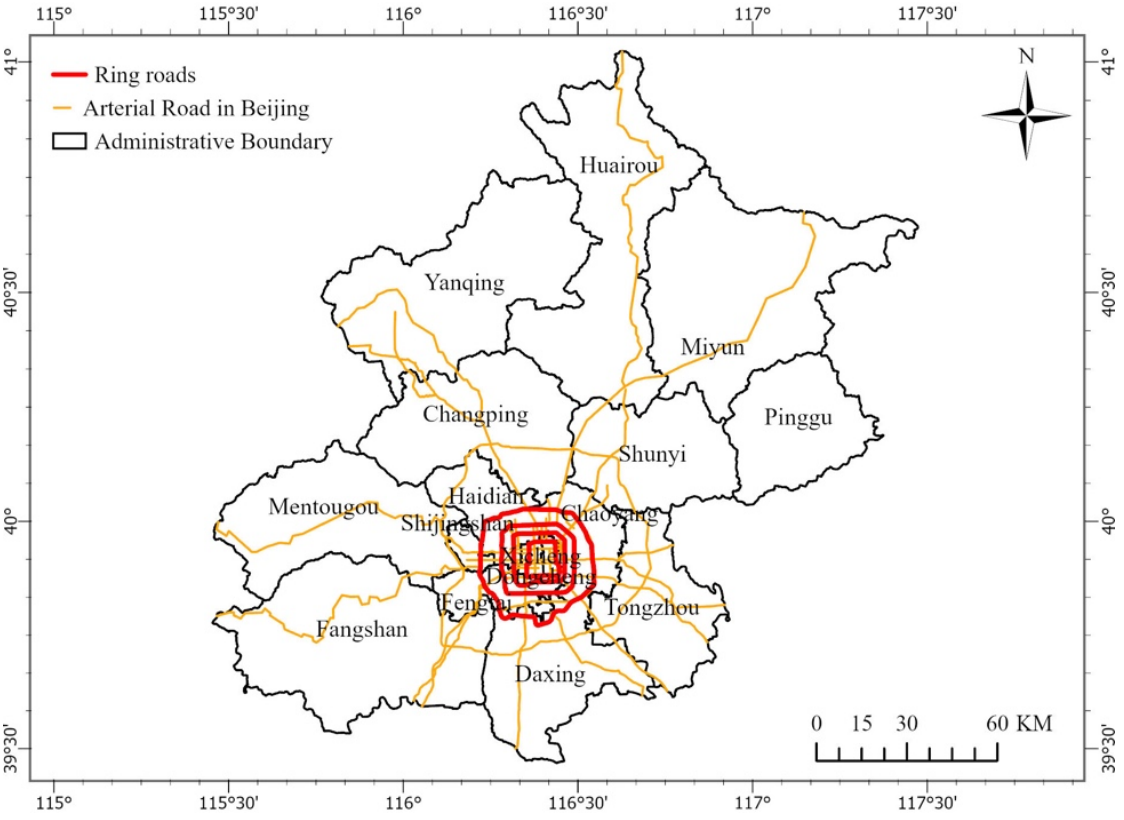
Figure 2. Case study area: Beijing (within the red lines).